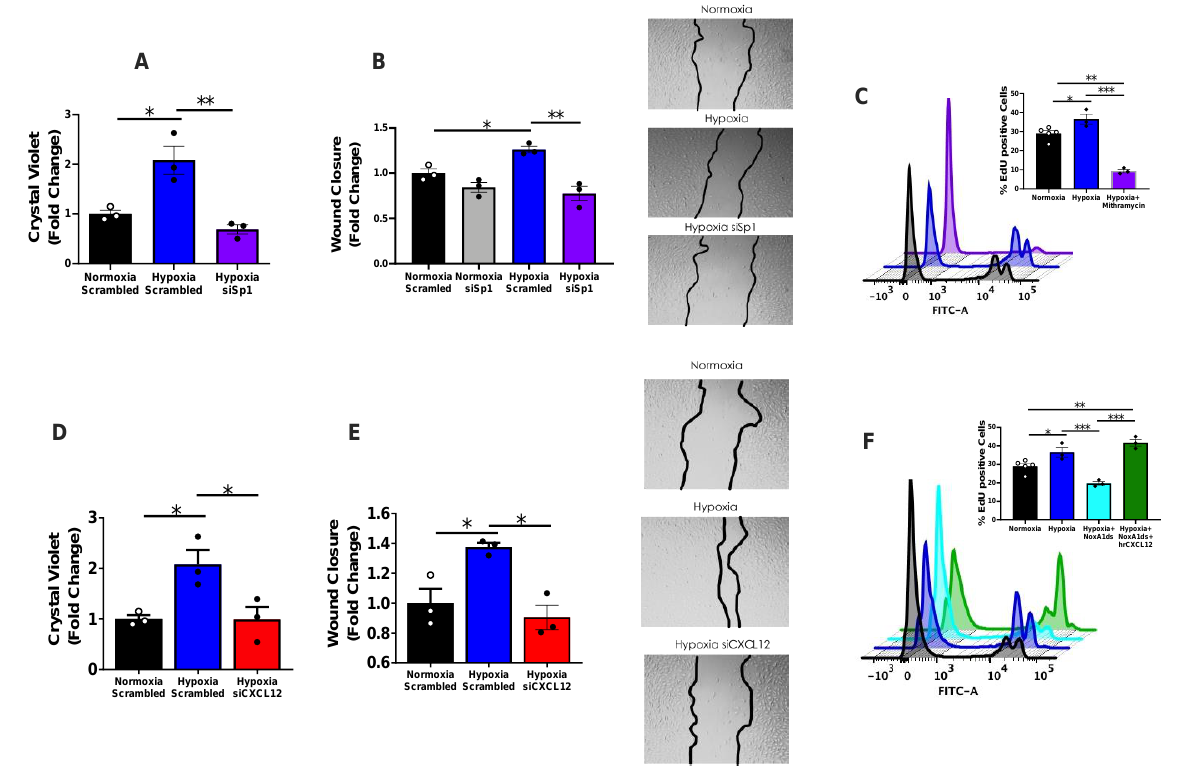
Figure 3. Hypoxia-induced proliferation and migration of pulmonary endothelial cells are NOX1- , Sp1- and CXCL12-dependent. ( A , B ) Normoxic vs. hypoxic hPAECs (1% O 2 ) were transfected with either scrambled or Sp1-targeted siRNA and analyzed by ( A ) Crystal Violet and ( B ). Wound closure assay; insets are wound images taken at 24 h. ( C ) hPAECs were subjected to normoxic vs. hypoxic (1% O 2 ) conditions following treatment with vehicle (DMSO) or Sp1 inhibitor mithramycin; proliferation was analyzed by Click-It TM EdU incorporation and flow cytometry. ( D , E ) hPAECs transfected with scrambled or CXCL12-targeted siRNA analyzed by ( D ). Crystal Violet and ( E ). wound closure assay. ( F ) hPAECs were treated with scrambled or Nox1-selective inhibitory peptide NoxA1ds, in addition to recombinant CXCL12 or vehicle control (PBS),and were subjected to hypoxia (1% O 2 ) or normoxia. Proliferation was analyzed by Click-It EdU incorporation and flow cytometry. Representative flow cytometry histograms depict populations of EdU-positive and -negative cells in a sample along the x axis, with right hand peaks indicating proliferating cells taken as percentage to the total number of cells in the sample (see Figure S1F for gating). Results were analyzed by one-way ANOVA and Holm–Sidak post hoc analysis ( A – F ). * p < 0.05, ** p < 0.01, *** p <